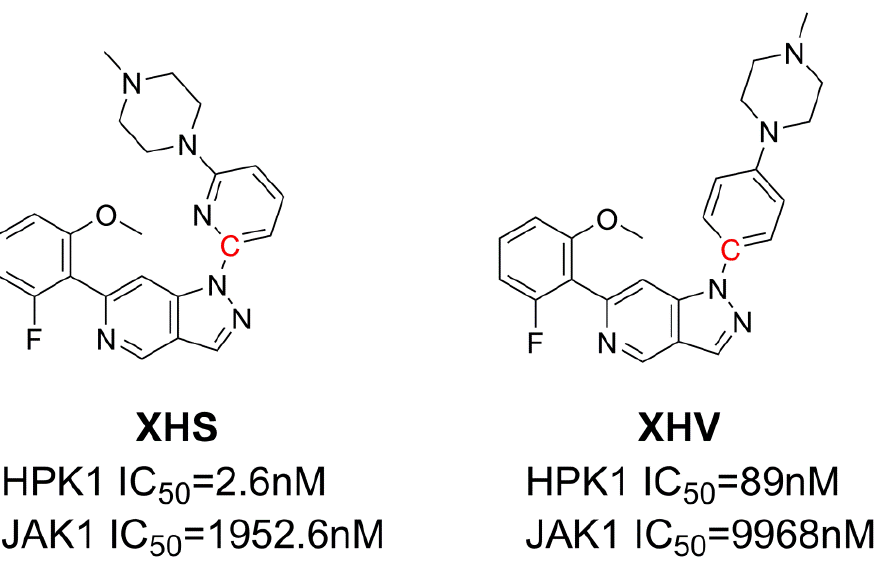
Figure 1. The chemical structures and IC 50 of the inhibitors studied in this work.